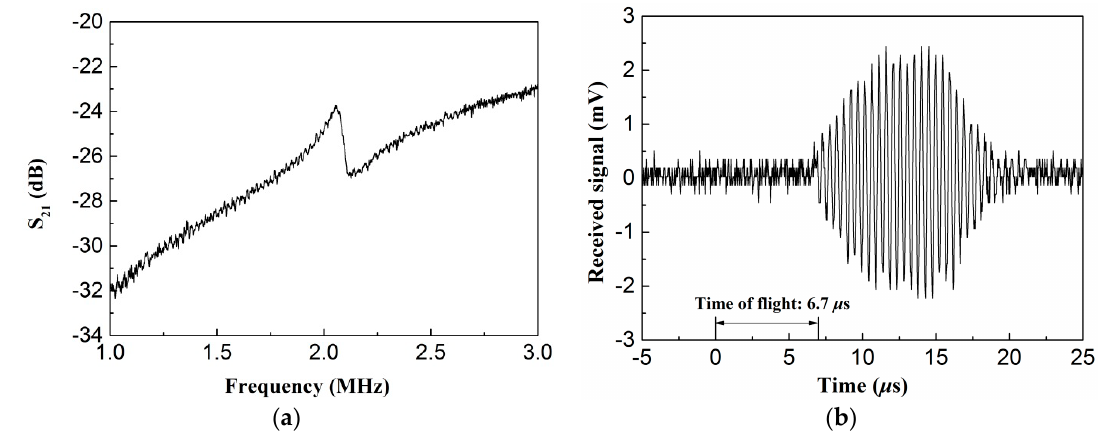
Figure 9. ( a ) Electrical insertion loss ( S 21 ) for CMUT; ( b ) Received signal actuated by 20 cycle burst sine